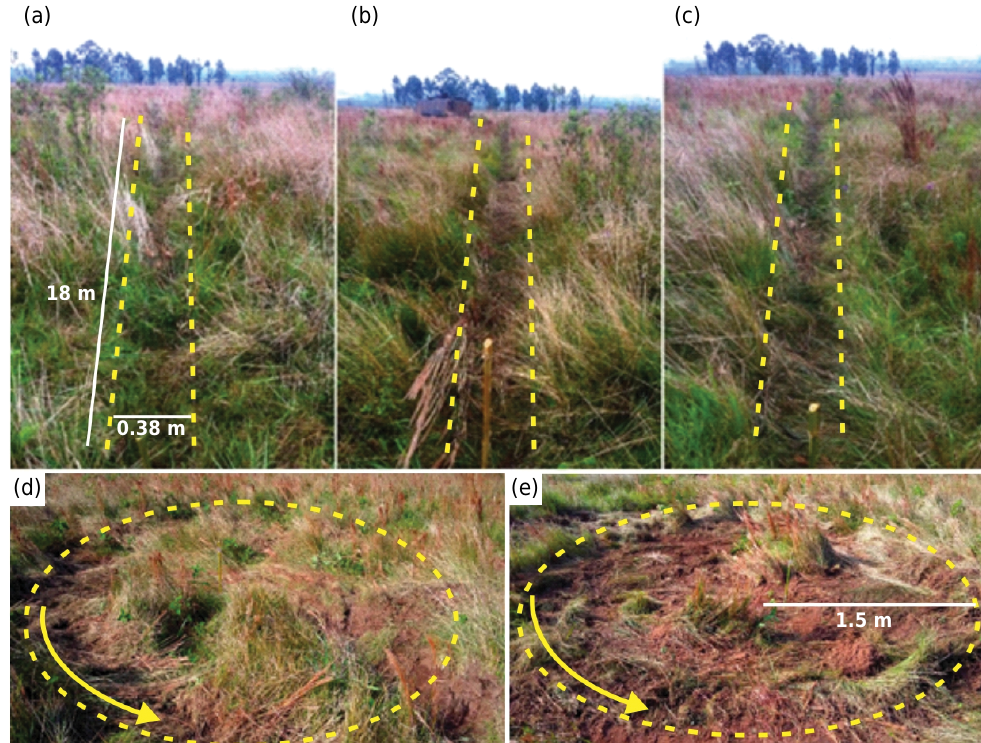
Figure 3. Study area after 1 pass (a), 2 passes (b), and 5 passes (c) of M113 BR in a straight line and 1 pivoting (d) and 2 pivoting maneuvers (e). Yellow dashes indicate the track